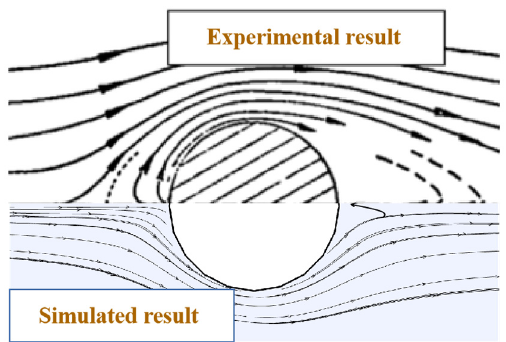
Figure 5. Comparison of simulated and experimental results of streamlines.